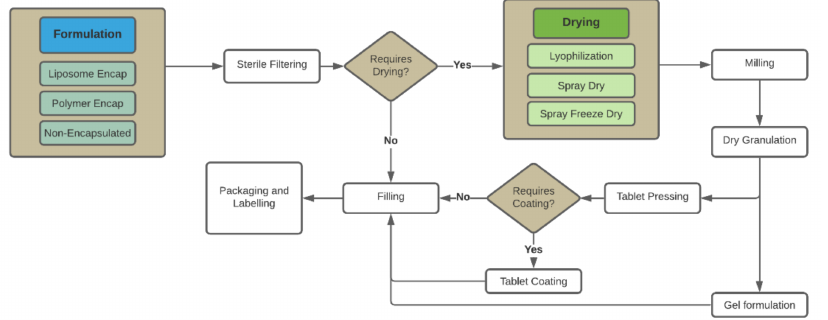
Figure 1. Process flow diagram for formulation, fill and finish. The drug substance (DS) is bulk formulated and sterile filtered. From there, the process developer chooses the necessary drying steps or fills in liquid, or semi-liquid (gel)